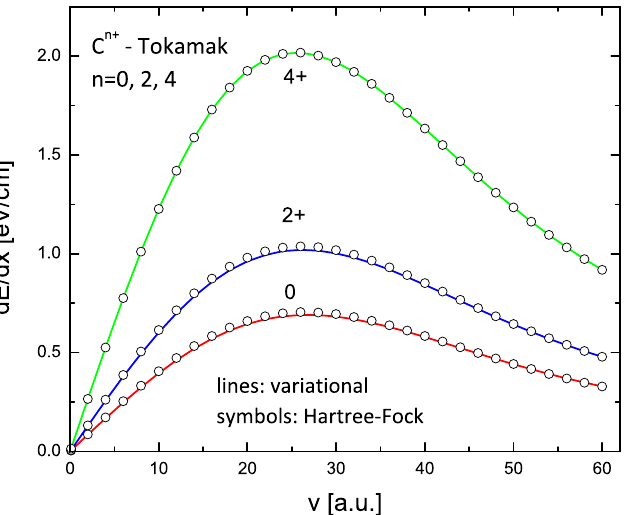
Figure 9. Energy loss of carbon in a Tokamak plasma with density n = 10 15 cm − 3 and temperature T = 10 8 K for three charge states: 0, 2+, and 4+. The lines are the calculations using variational form factors (two-parameter formulation); the circles are the calculations using HF form factors.